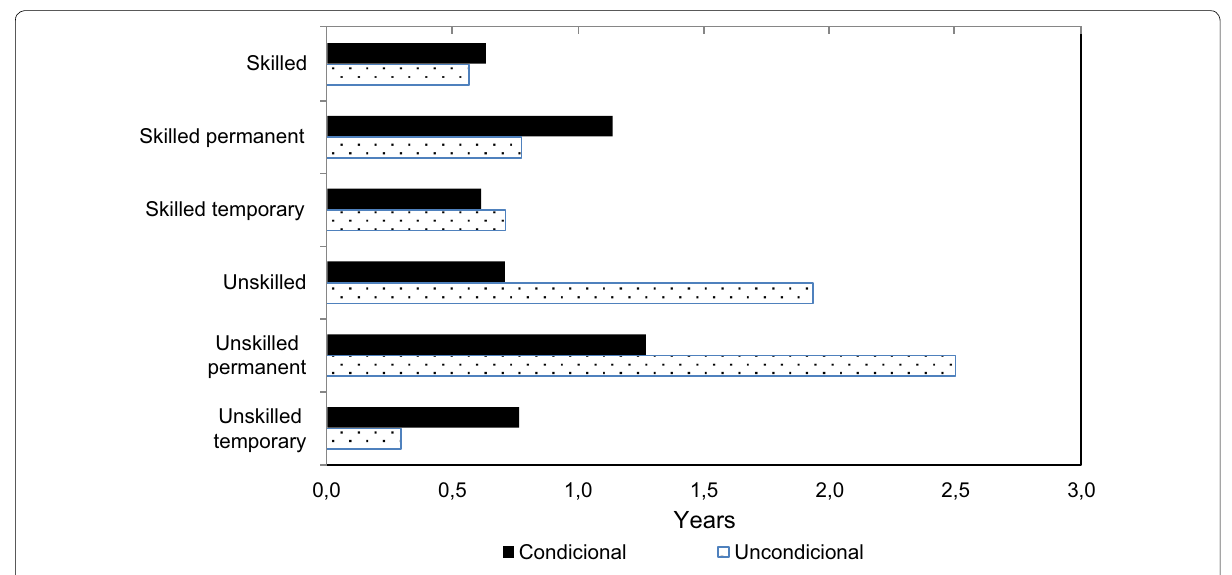
Fig. 4 Halfway of labour demand adjustments (2000–2013) ( Source Dane-AMS and authors’ calculations)